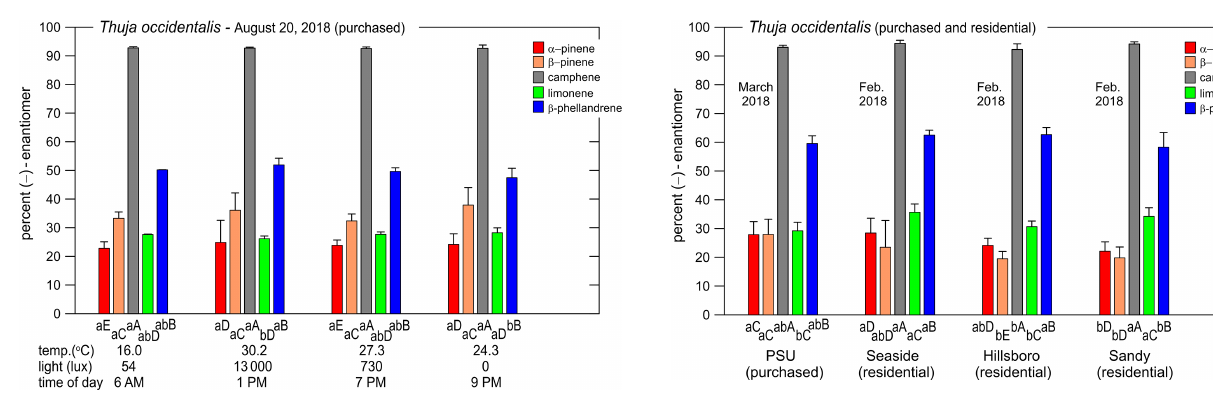
Figure 5. Percent of the ( − )-enantiomer for five monoterpenes in nursery-purchased (March 2018) and residential (February 2018) samples of Thuja occidentalis . For a given sample location, the largest value is designated “A”; thereafter, a different capital letter indicates a significant difference between the monoterpenes. For a given monoterpene, the largest value is designated “a”; thereafter, a different lowercase letter indicates a significant difference between the locations. The error bars are ± 1SD. The data values are given in Table 5. The data for the “PSU (purchased)” plants also appear in Fig.